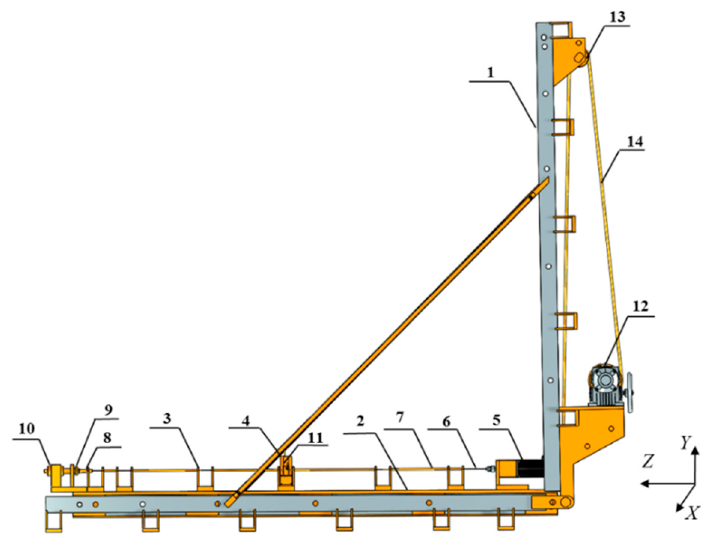
Figure 4. Schematic diagram of the experimental setup.